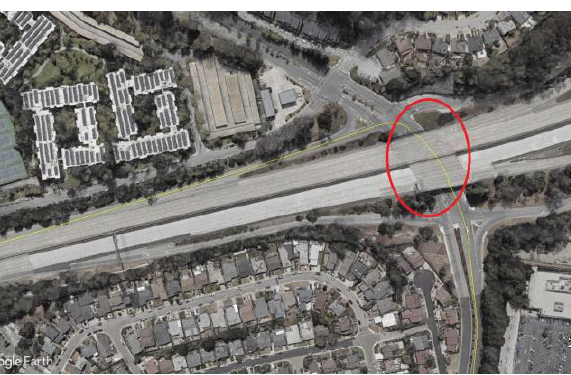
Figure 22. Locations of receiver for epoch 300 to epoch 400 (Red circle shows receiver’s location for epoch 354 to epoch